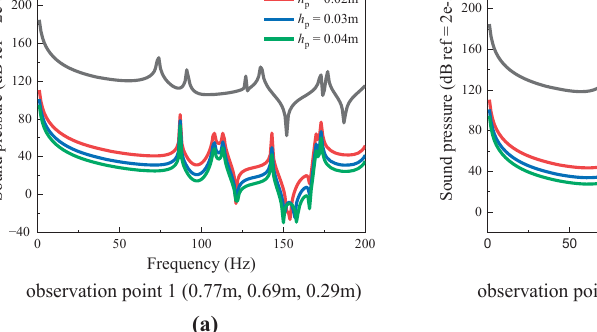
Figure 11. The effect of different thickness h p on the sound pressure response with the excitation of point sound source in the coupled